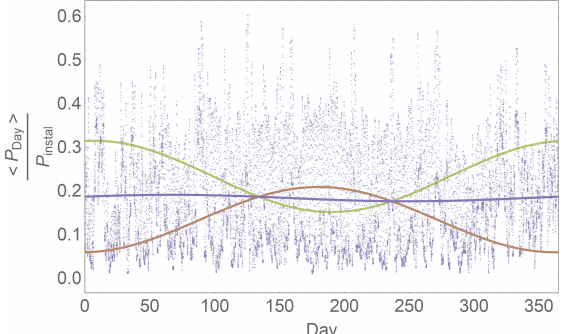
Figure 4. Solid line: daily averaged capacity factor of PV (orange) and wind (green) productions and of a 50–50 mix (purple) throughout the year. Data points: instant value of the 50–50